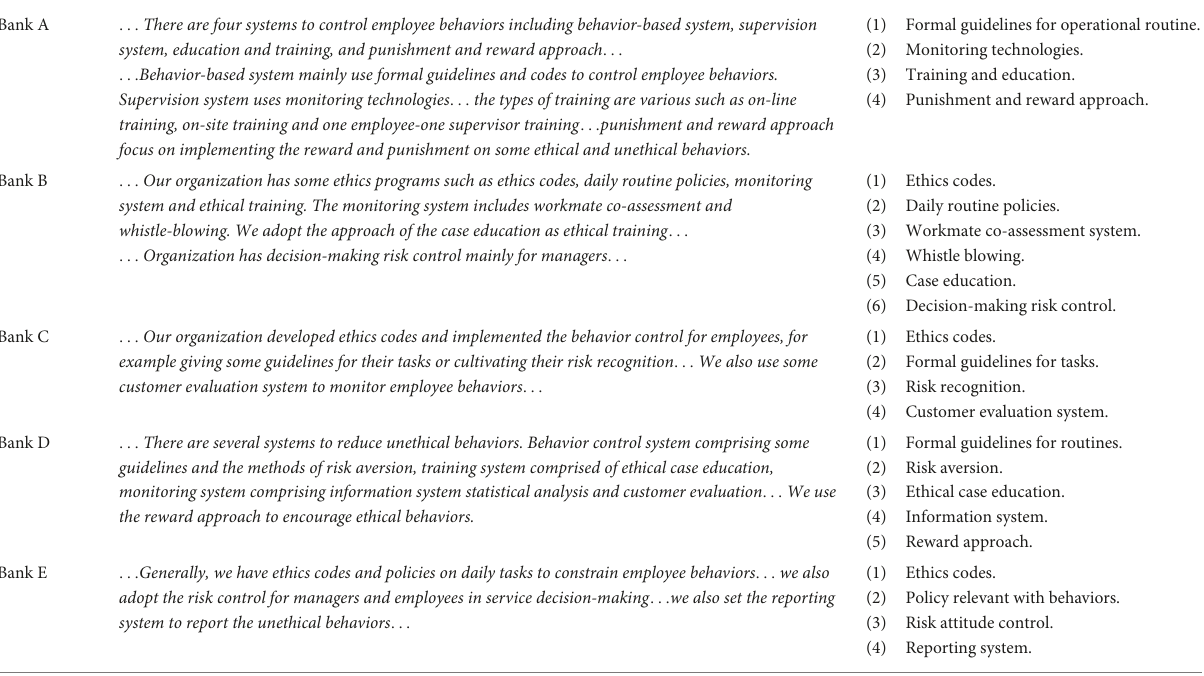
TABLE 2 Content analysis of control practices relevant to ethical behavior in the professional service